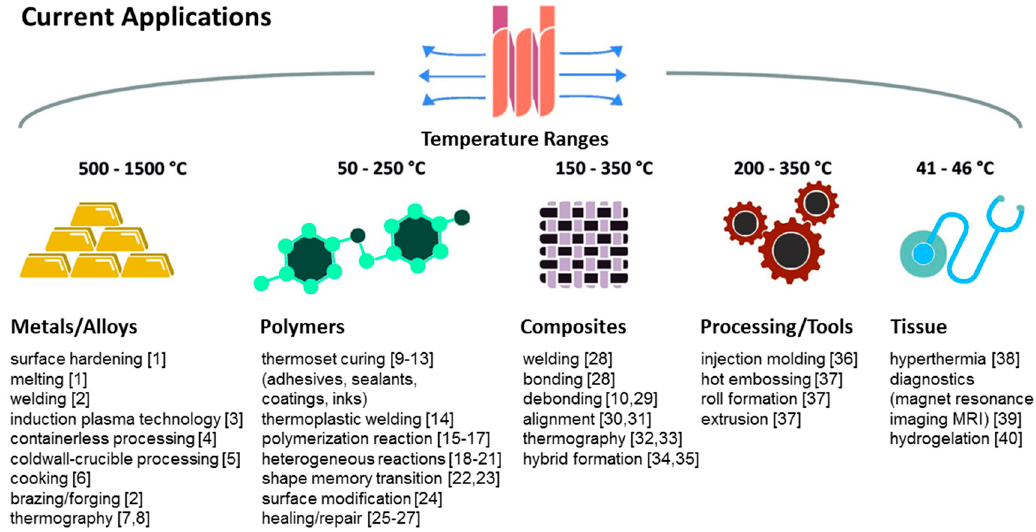
Figure 1. Different applications of induction heating for various materials and their processing temperatures.